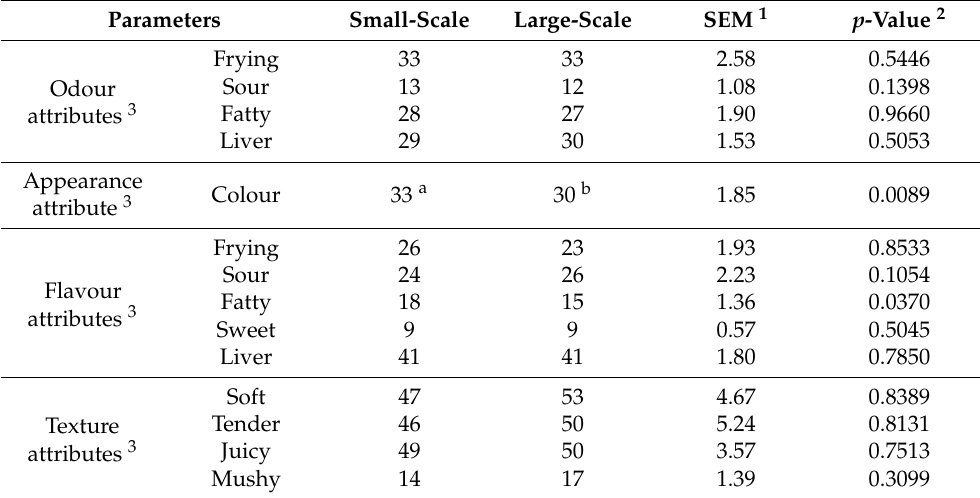
Table 2. Warner–Bratzler shear force values and sensory analyses comparing lamb slaughtered in the small-scale system ( n = 10) and large-scale system ( n =